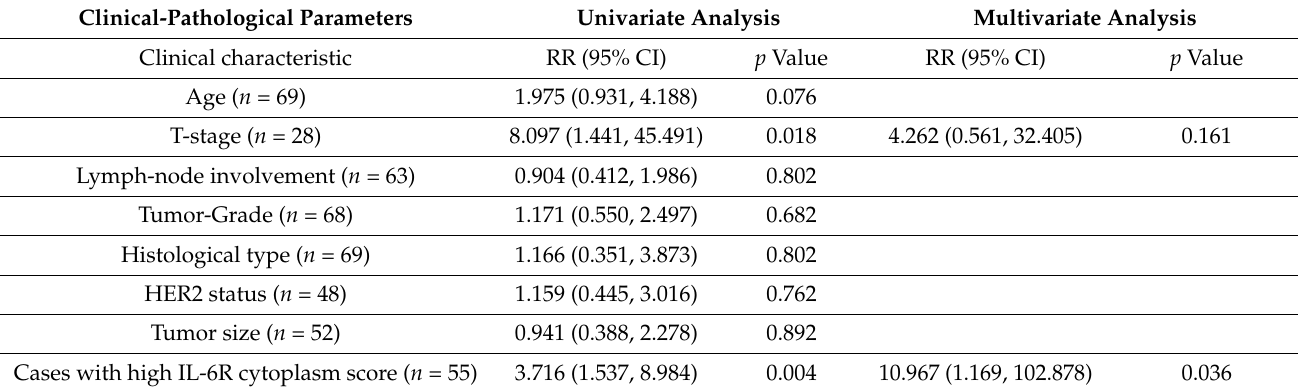
Table 3. Cox regression analyses of overall survival in ER+ breast cancer patients.